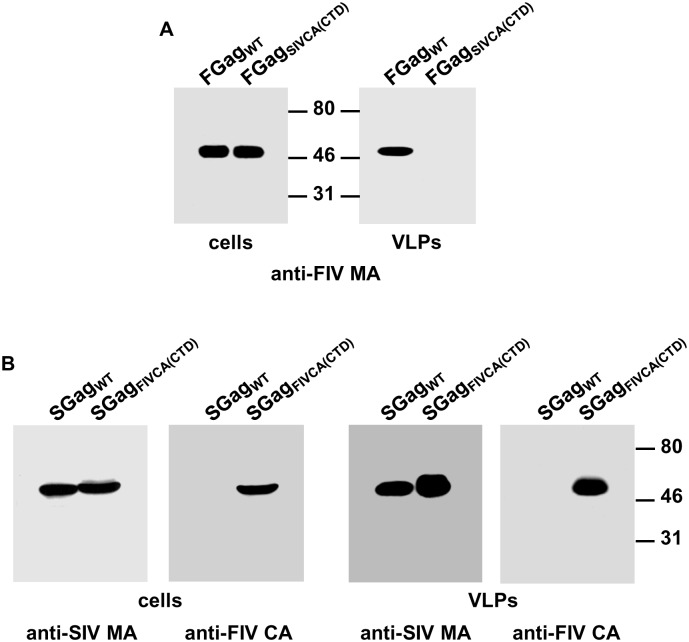
Comparative analysis of the effect of exchanging the FIV and SIV CA-CTD on chimeric Gag assembly.COS-7 cells infected with the vTF7-3 recombinant vaccinia virus were transfected with plasmids directing the synthesis of wild-type FIV Gag (FGagWT) or FIV GagSIVCA(CTD) (FGagSIVCA(CTD)) (A), and, in parallel, with plasmids coding for wild-type SIV Gag (SGagWT) or SIV GagFIVCA(CTD) (SGagFIVCA(CTD)) (B). Cell and VLP lysates were analyzed for the presence of Gag proteins by Western blotting using the anti-FIV MA serum (A), or the anti-SIV MA serum and the anti-FIV CA MAb (B). Numbers indicate the positions of the molecular weight standards (in kDa). Results shown are representative of three independent experiments.